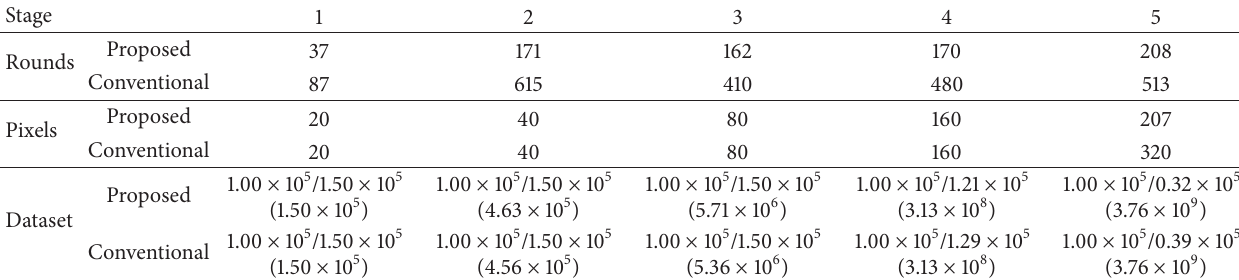
Table 2: Information of the trained classifiers for face detection at each of 5 stages.